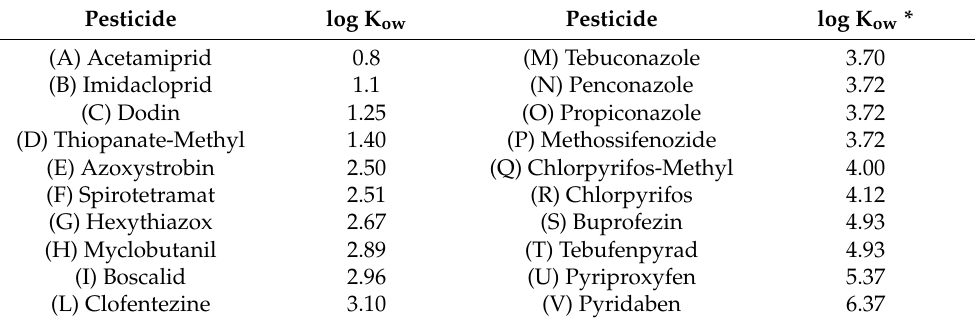
Table 2. Analytical standards (pesticides) used for the extraction with CS_GO composite membranes. Pesticide log K ow